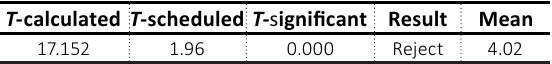
Table 15. The results of the main